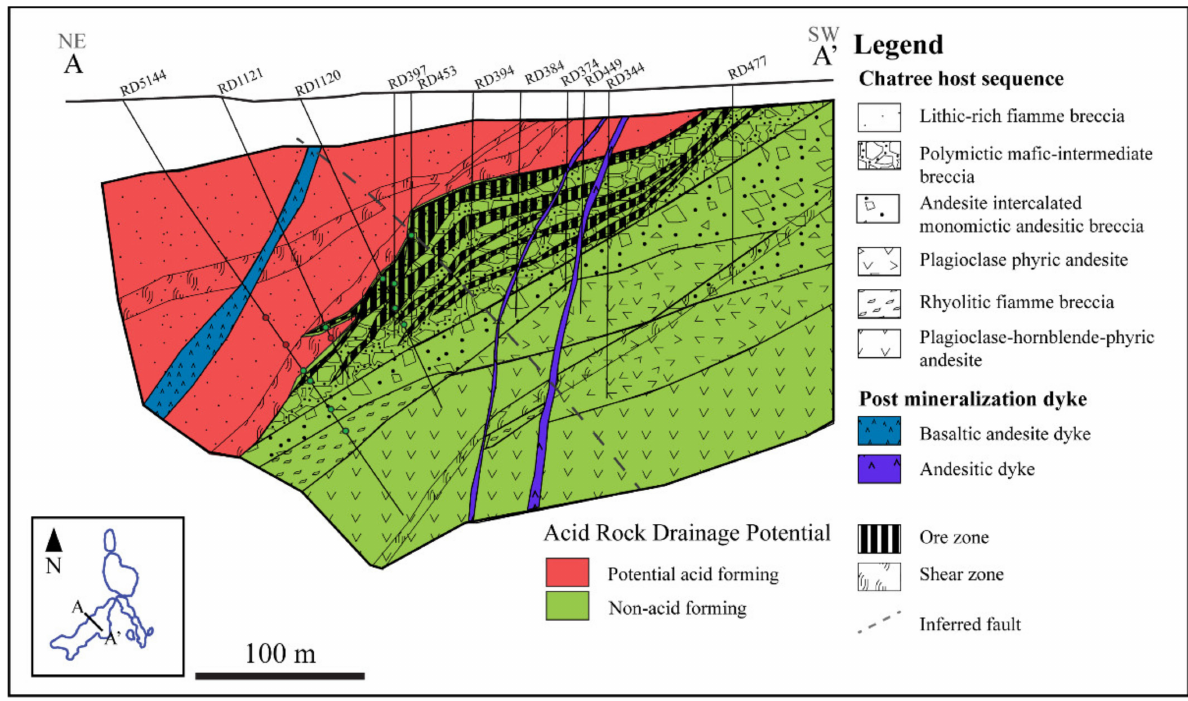
Figure 8. ARD potential classification of the ore and host rocks of the H ore lens along the A-A’ cross section, indicating that the lithic-rich fiamme breccia unit in hanging wall is classified as PAF, while the ore zone and host rocks in the footwall are in the NAF